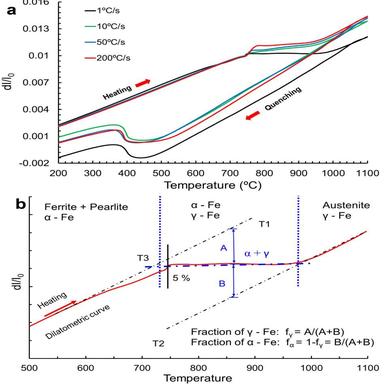
a) Dilatometry curves from dilatometry tests with different heating rates; b) Schematic diagram of an experimental dilatometry curve (measured at 1 o C/s) to calculate AC1 and AC3 temperatures via tangent intersection principle and lever rule.